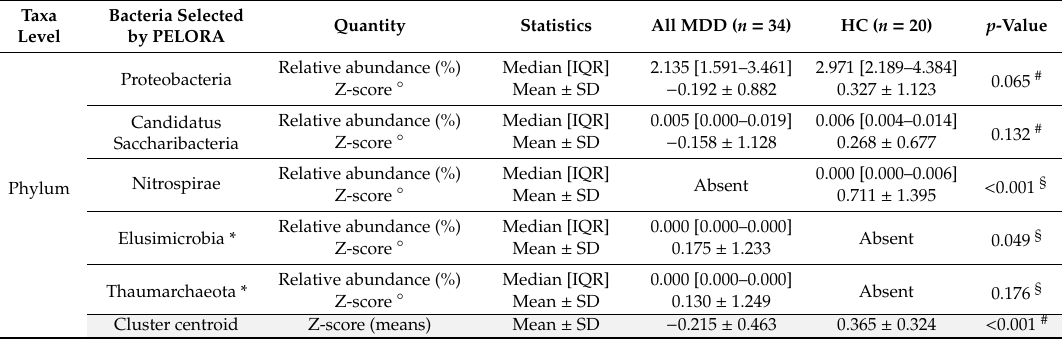
Figure 1. Gut microbiota composition (i.e., mean relative abundance %) at phylum, family, genus, and species levels grouped by patients with major depressive disorder (MDD) and healthy controls (HC). Table 2. Results from the penalized logistic regression analysis (PELORA) algorithm which identifies pathways of bacterial populations that best discriminate all patients with major depressive disorder (MDD) from healthy controls